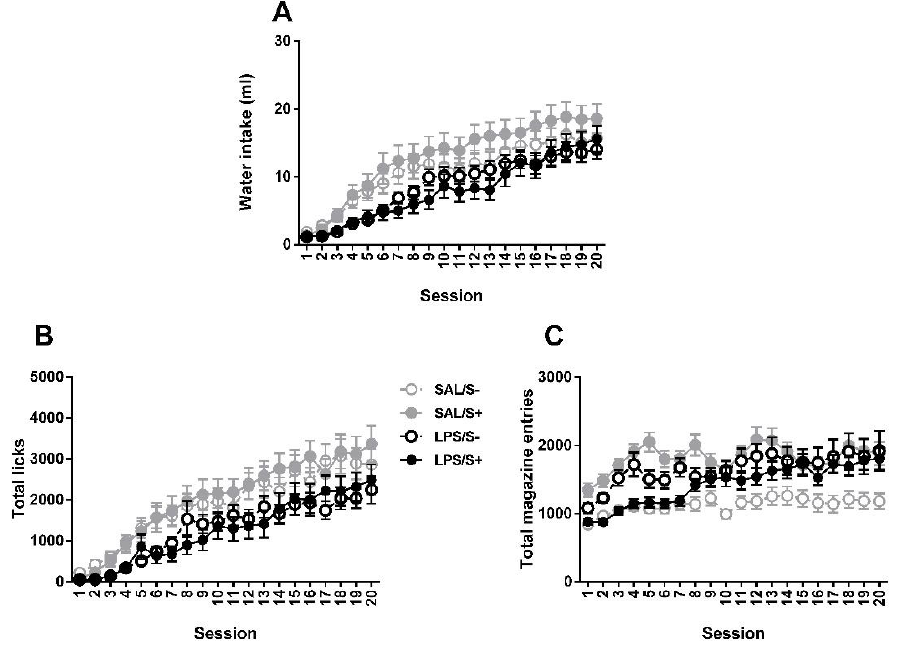
Figure 7. Schedule-induced polydipsia (SIP) acquisition in saline-control (SAL/S-), LPS-control (LPS/S-), saline-stress (SAL/S+), or LPS-stress (LPS/S+) groups ( n = 12). ( A ) Mean water intake (in milliliters), ( B ) total licks, and ( C ) total magazine entries are shown across 20 sessions. No effect of LPS or stress was found in any of the measures. Data are represented as mean ± SEM.